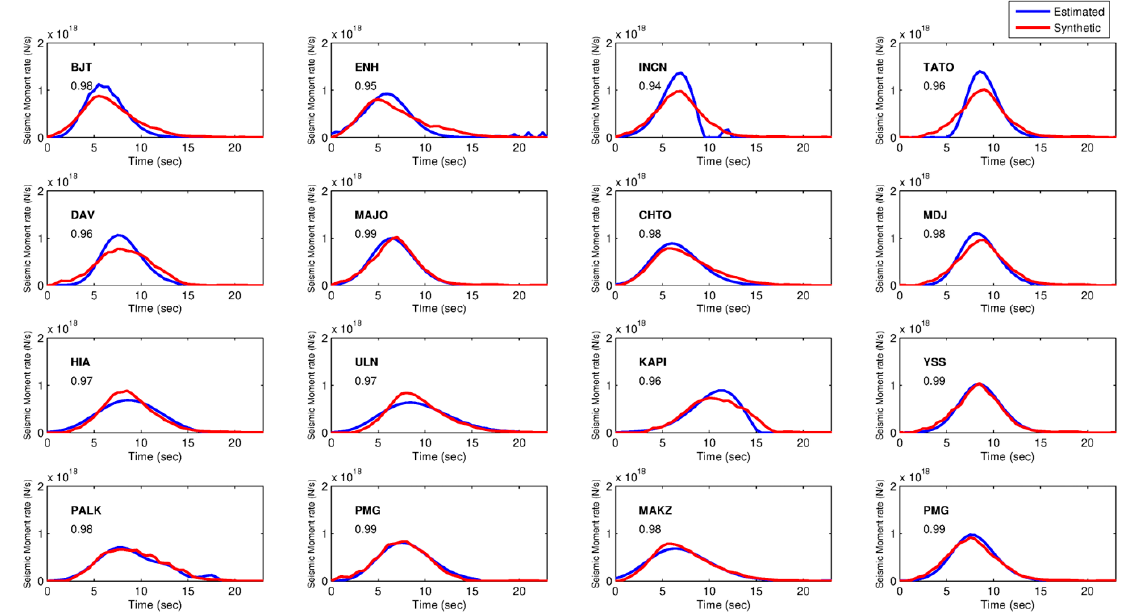
Figure 3. Comparison of ASTFs (blue line) for the Meinong event calculated using the proposed method for handling teleseismic data and ASTFs (red line) calculated using the inverted source model. The correlation coefficients between the estimated and synthetic ASTFs were all above 0.94.